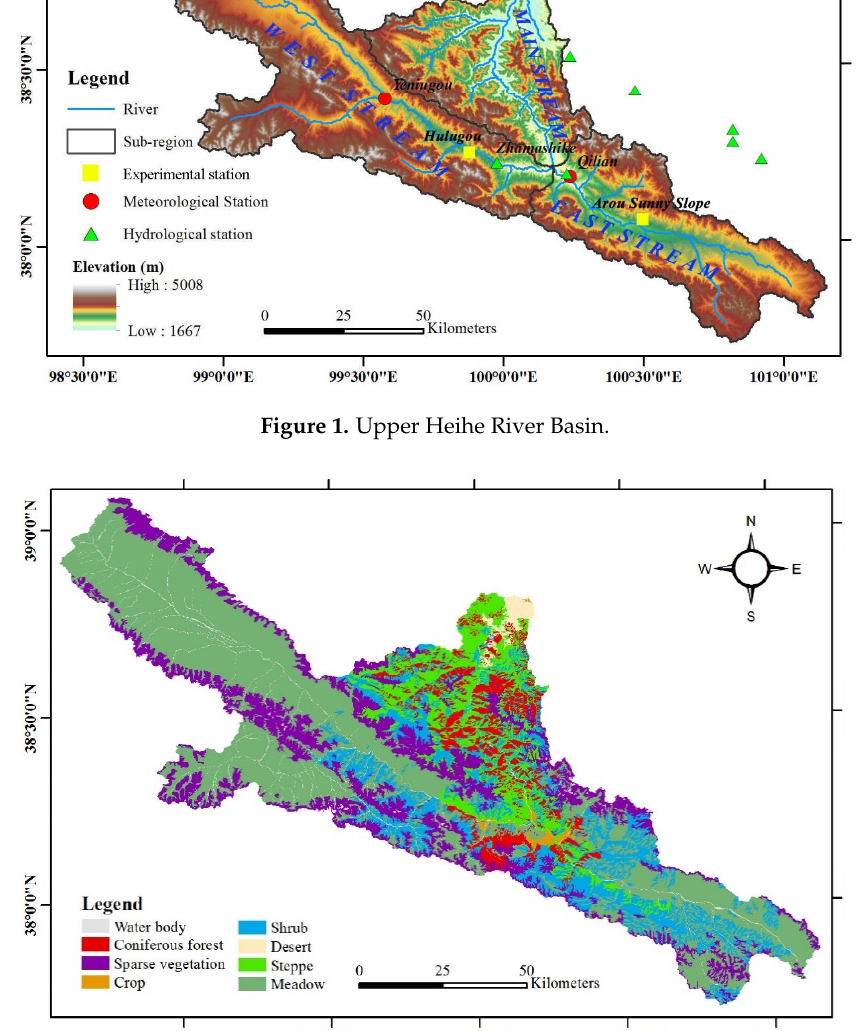
Figure 2. Vegetation map of the upper Heihe River Basin.